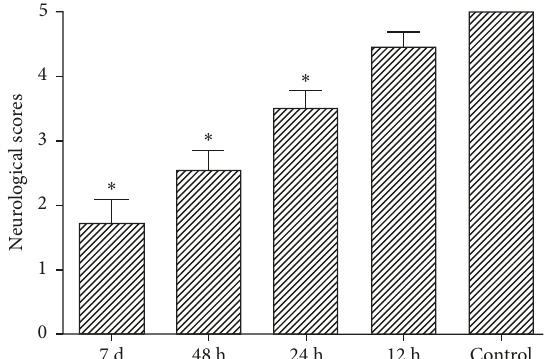
Figure 5: Changes in neurological scores in different groups. The neurological scores were significantly lower in rats with 24h, 48h, and 7d groups compared with the control group. However, no statistically significant interactions between the 12h group and the control group were